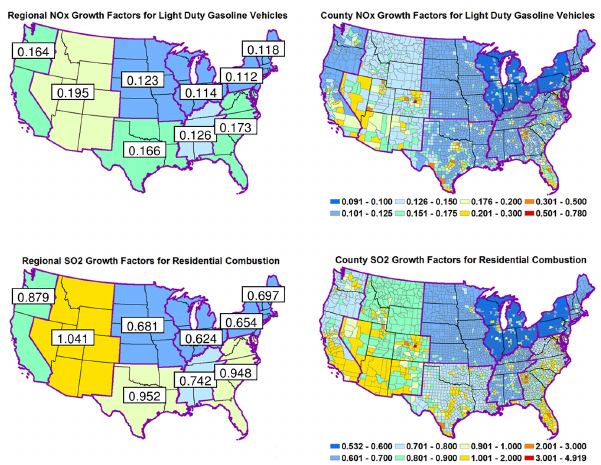
Figure 5. Light duty gasoline vehicle (LDGV) regional NO x growth factors, generated by MARKAL, are shown in the top left panel. The top right panel shows corresponding county-level growth factors after adjustments are made to account for ICLUS county- level population changes. Similarly, the bottom two panels show regional- and county-level SO 2 growth factors for residential com- bustion, before and after population-based adjustments have been made.